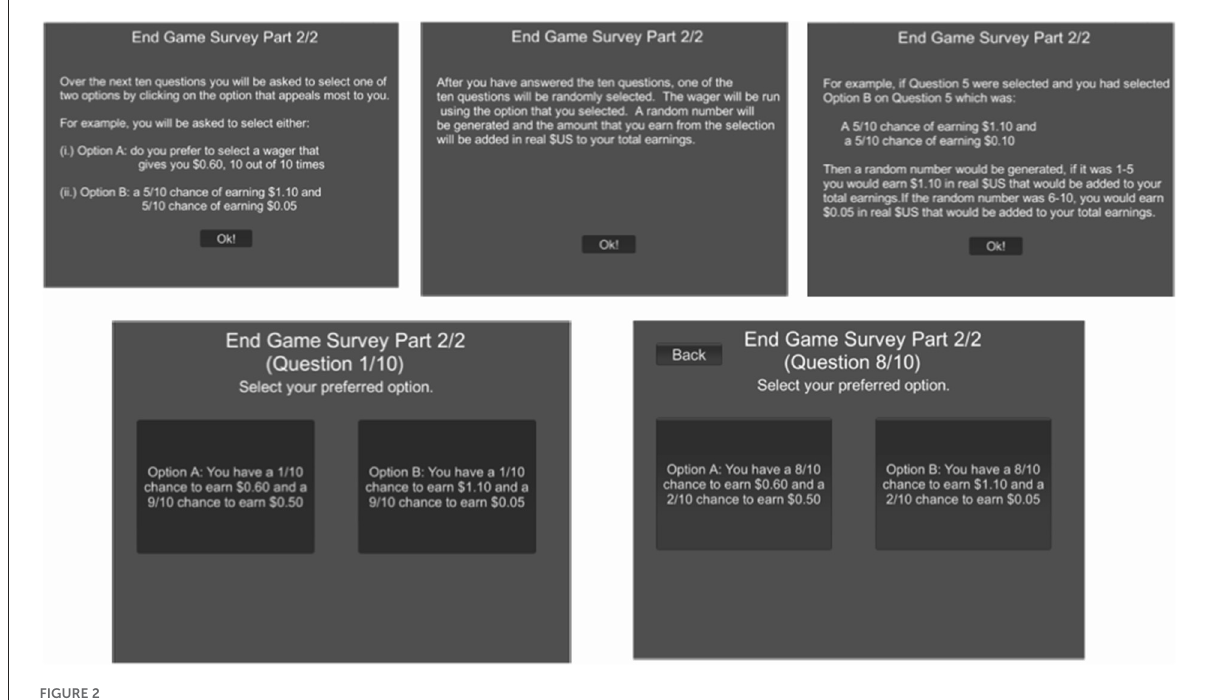
FIGURE2 Multiple price list (MPL) survey